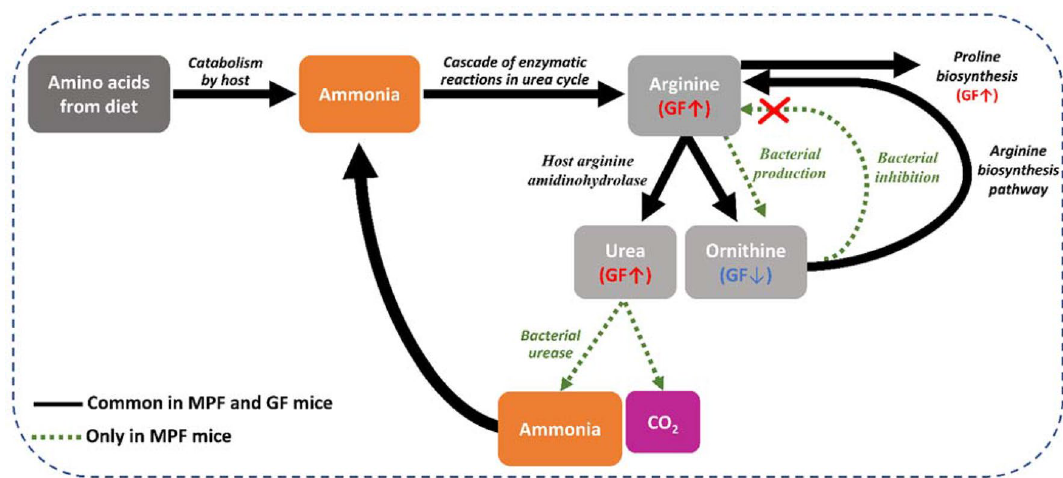
Figure 9. Summary of the fate of key metabolites (arginine, proline, urea, and ornithine) in the arginine and proline metabolism (urea cycle). Catabolism of dietary amino acids leads to the production of ammonia. Ammonia further undergoes conversion to urea via the urea cycle. In mammals with conventional gut microbiota, urea is broken down to ammonia and CO 2 by bacterial urease. The ammonia produced by microbiota is released into the GI tract and is taken up by host cells and serves as a substrate to synthesize arginine in the urea cycle. Within the urea cycle, arginine is then converted into urea and ornithine. Simultaneously, ornithine can also be synthesized by gut bacteria. Ornithine produced from the two mentioned pathways, can enter the arginine biosynthesis pathway to synthesize more arginine; nevertheless, the bacterial inhibition of arginine biosynthesis can be inhibited by some bacteria. This excess amount of arginine can either enter the arginine and proline biosynthesis pathways or the urea cycle.